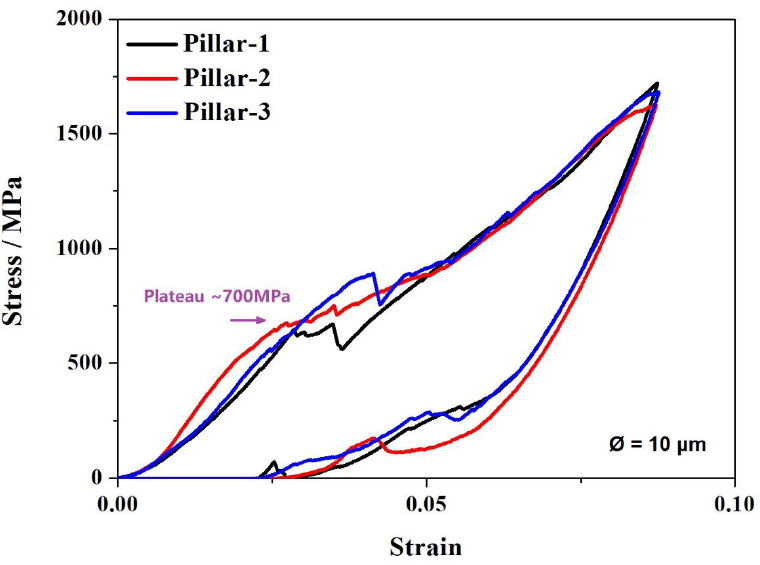
Figure 15. Micro-pillar compression test result of solution treated low Ms Ti-Ni-Hf-Cu-Nb